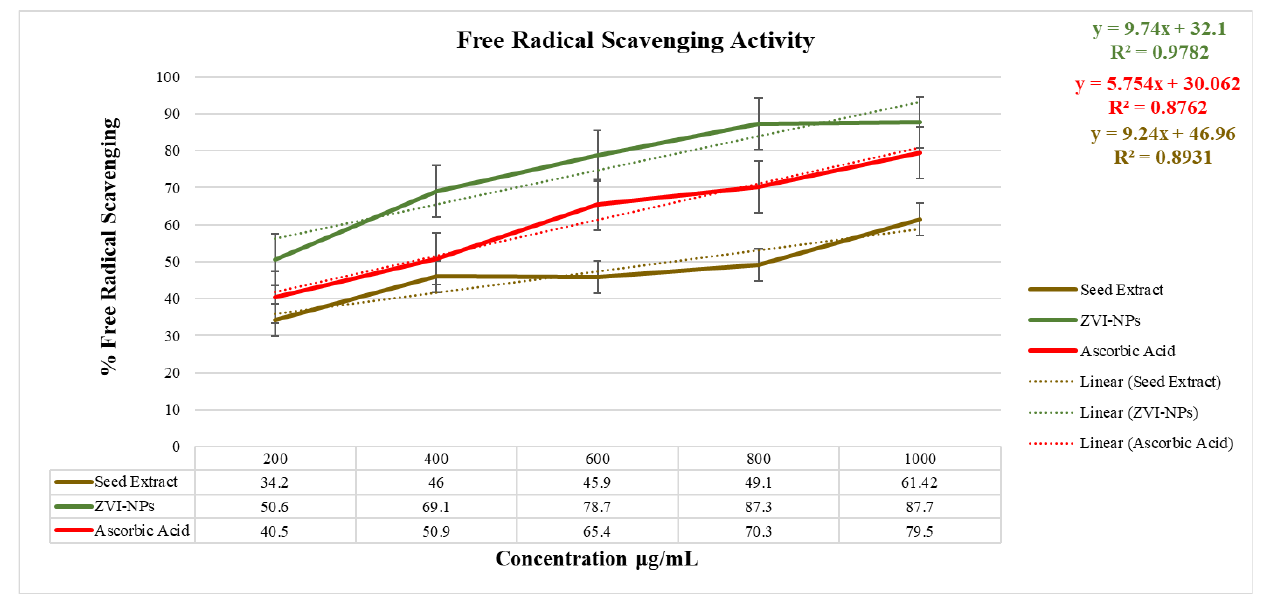
Table 6. Calculated IC50 values of U87-MG and HEK cell lines . Figure 9. Graphical representation for the calculation of IC50 and antioxidant activity showing the highest scavenging percentage of ZVI - NPs (87.7%) at the concentration of 1000 µ g/mL. 2.9. Cytotoxicity Testing of ZVI-NPs Cytotoxicity testing of ZVI-NPs gave pre-eminent results against U87-MG and HEK